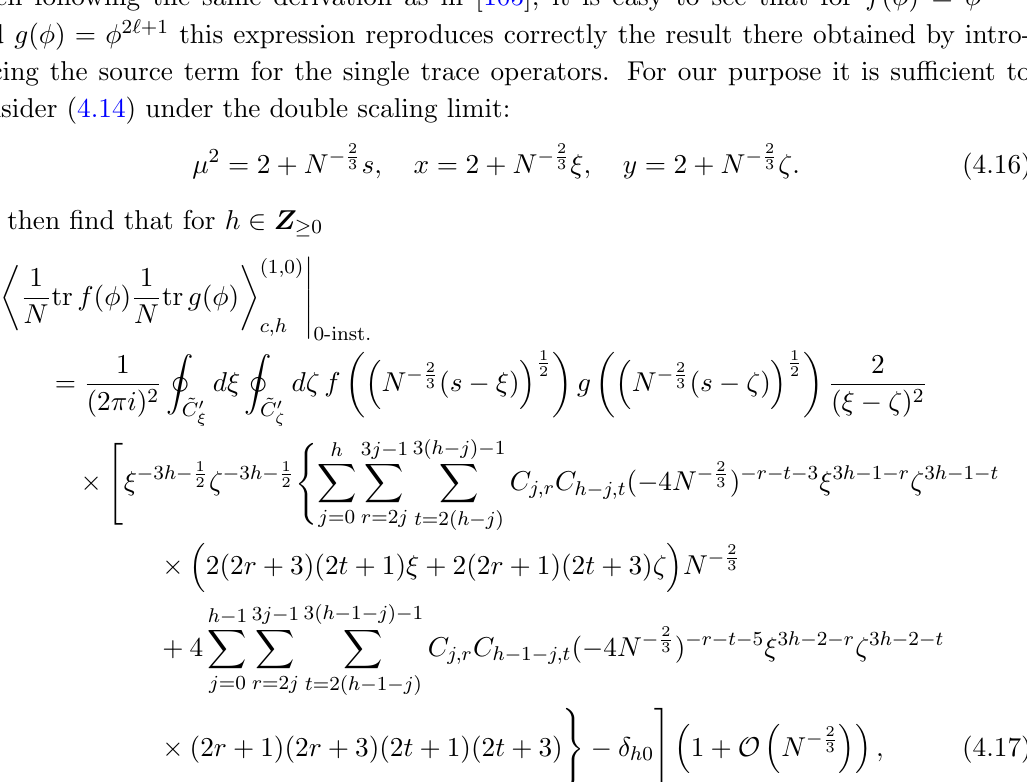
on the complex (cid:24) (cid:24)